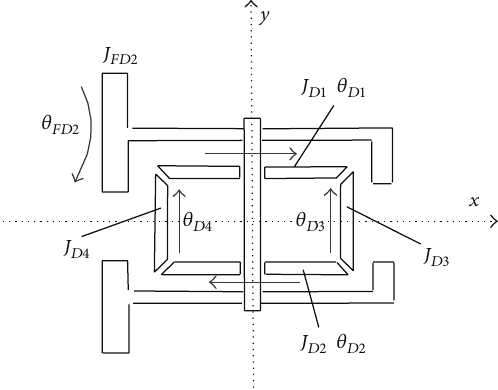
Figure 10: Structure diagram of the